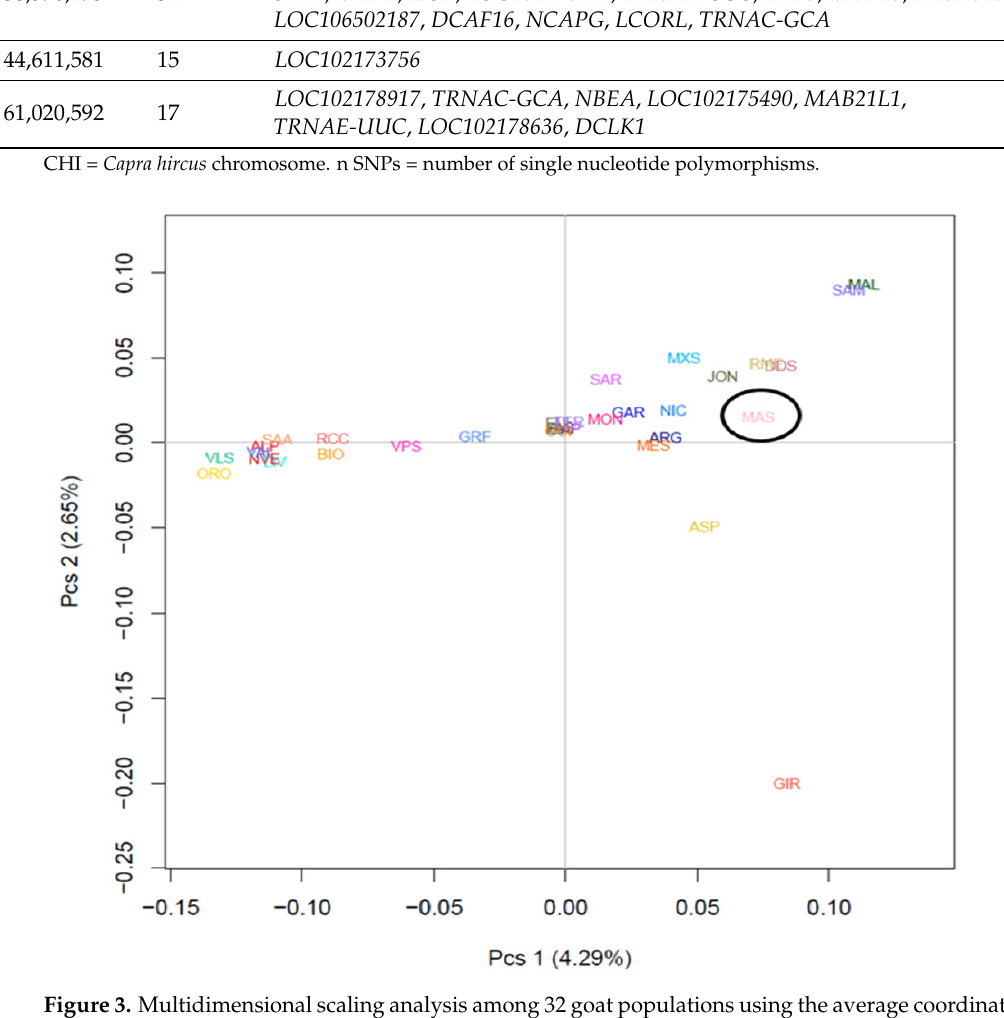
Figure 4. Multidimensional scaling analysis between Mascaruna and the southern goat popula- tions. For full definition of the populations, see Table 1.